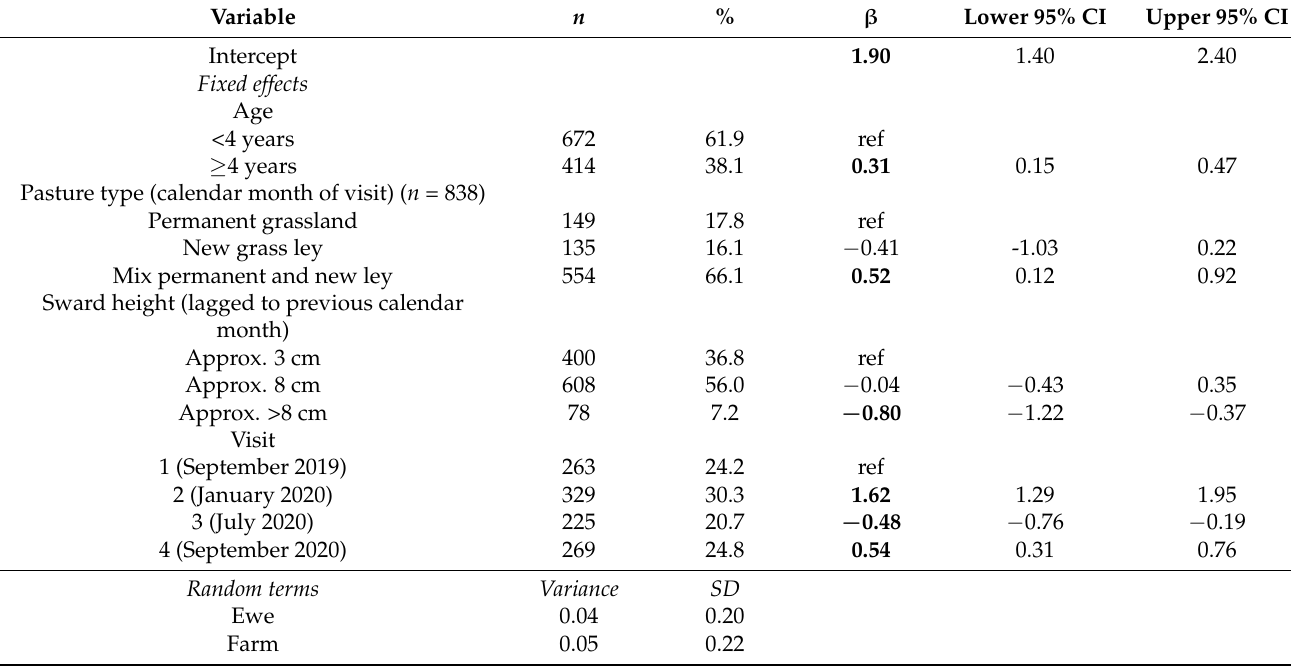
Table 10. Final multivariable model of the associations with the number of feet affected by white line disease for 1086 sheep-level observations of 396 ewes